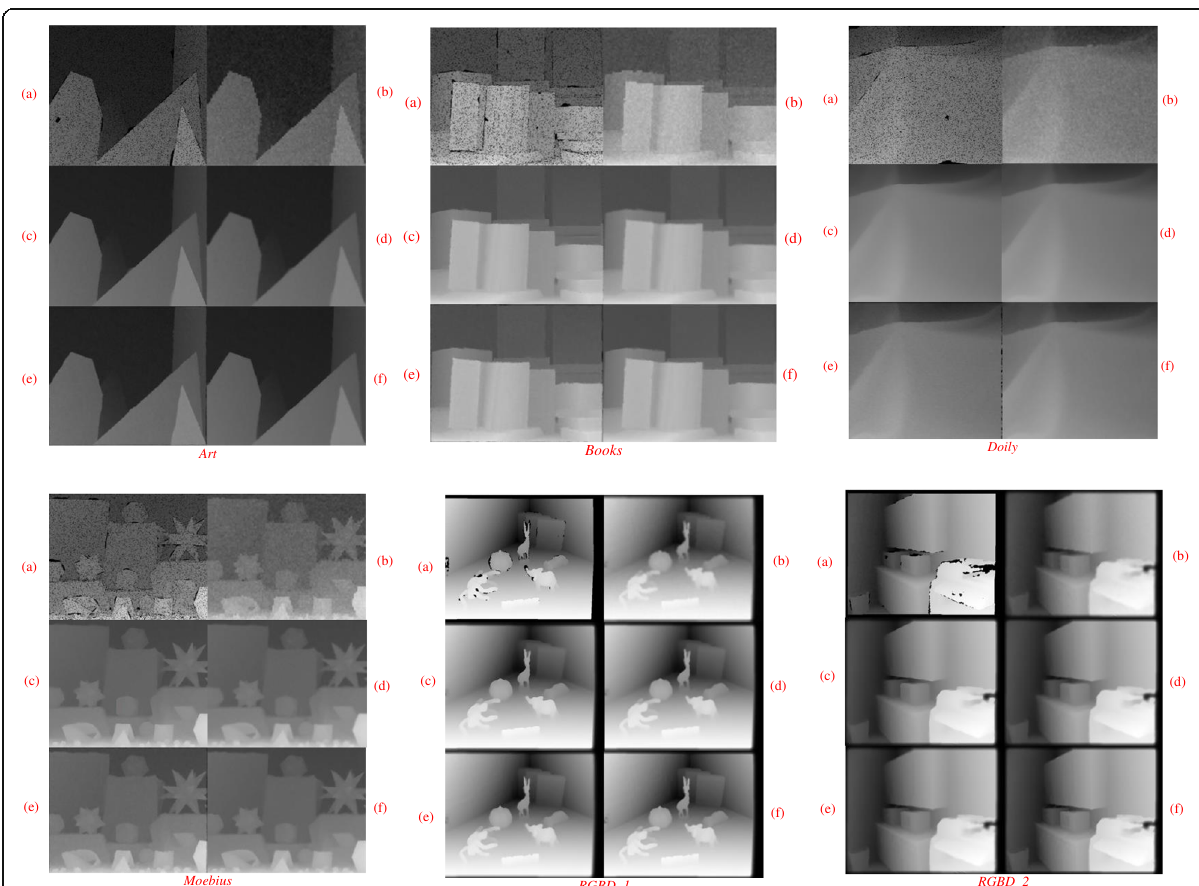
Fig. 7 Results of the depth enhancement coupled with hole filling results obtained by a noisy depth map, b joint bilateral filter (JBF) [16], c intensity guided depth superresolution (IGDS) [39], d compressive sensing based depth upsampling (CSDU) [40], e adaptive joint trilateral filter (AJTF) [18], and f the proposed AMF for Art , Books , Doily , Moebius , RGBD_1 , and RGBD_2